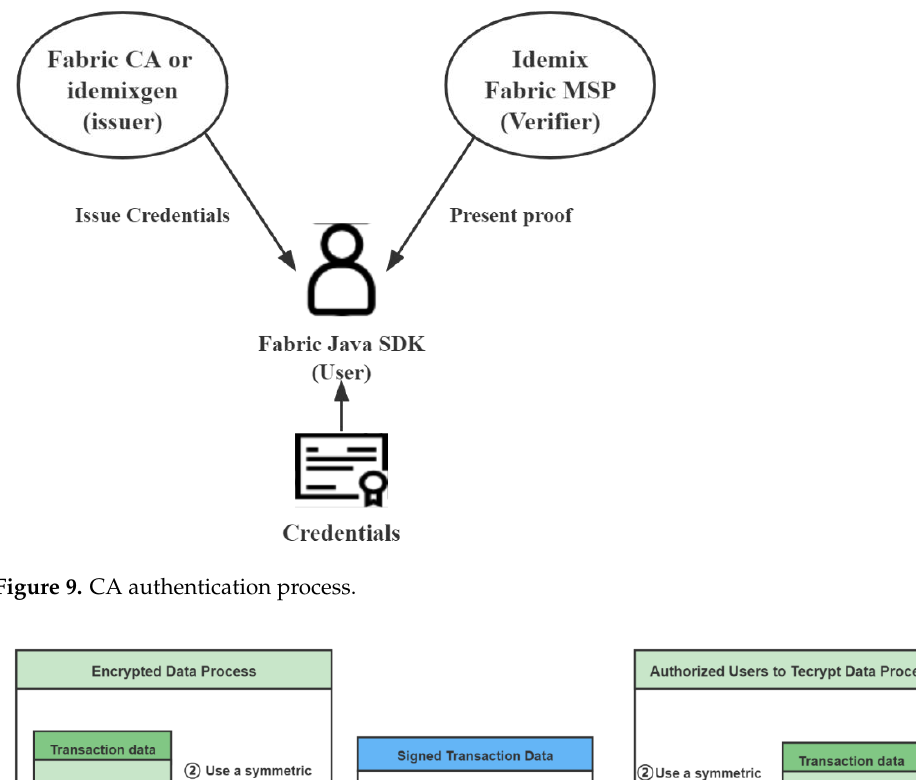
Figure 9. CA authentication process.